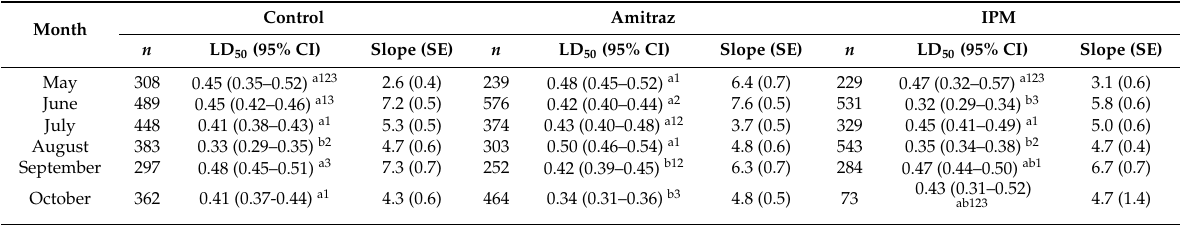
Table 1. Honey bee phenothrin bioassay summary. The LD 50 values are in shown in units of ng phenothrin/mg bee. The LD 50 values were considered significantly different if the 95% CI of the LD 50 values did not overlap between colonies or test dates. Letters and numbers beside LD 50 values indicate significant differences in rows and columns, respectively.